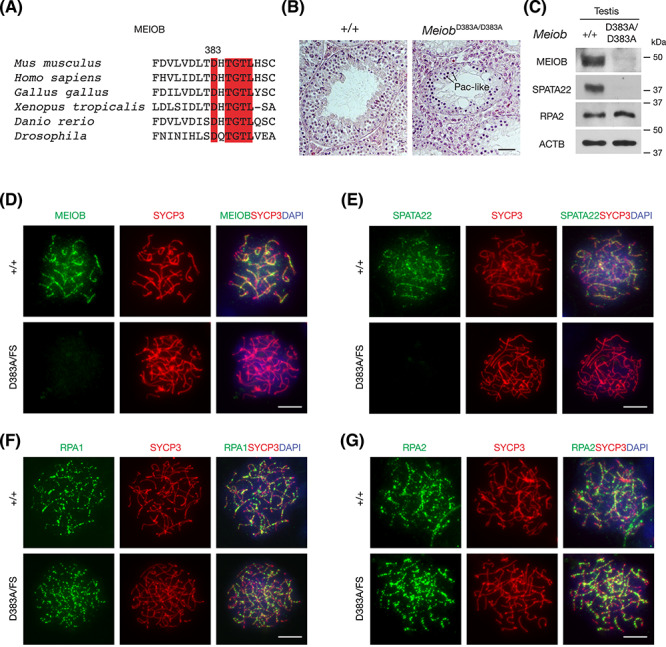
The MEIOB D383A mutation causes meiotic arrest and infertility in mouse. (A) Conservation of the D383 residue in MEIOB across species. The conserved residues are highlighted in red. (B) Histological analysis of testes from 8-week-old wild-type and MeiobD383A/D383A mice. Pac-like, pachytene-like. Scale bar, 50 μm. (C) Western blot analysis of wild-type and MeiobD383A/D383A testes. ACTB serves as a loading control. (D–G) Immunofluorescence analysis of surface nuclear spreads of spermatocytes from adult wild-type and MeiobD383A/FS (founder tag# 74). Spread nuclei of spermatocytes were immunostained with anti-MEIOB (D), anti-SPATA22 (E), anti-RPA1 (F), and anti-RPA2 (G). DNA was stained with DAPI. Scale bars, 10 μm.